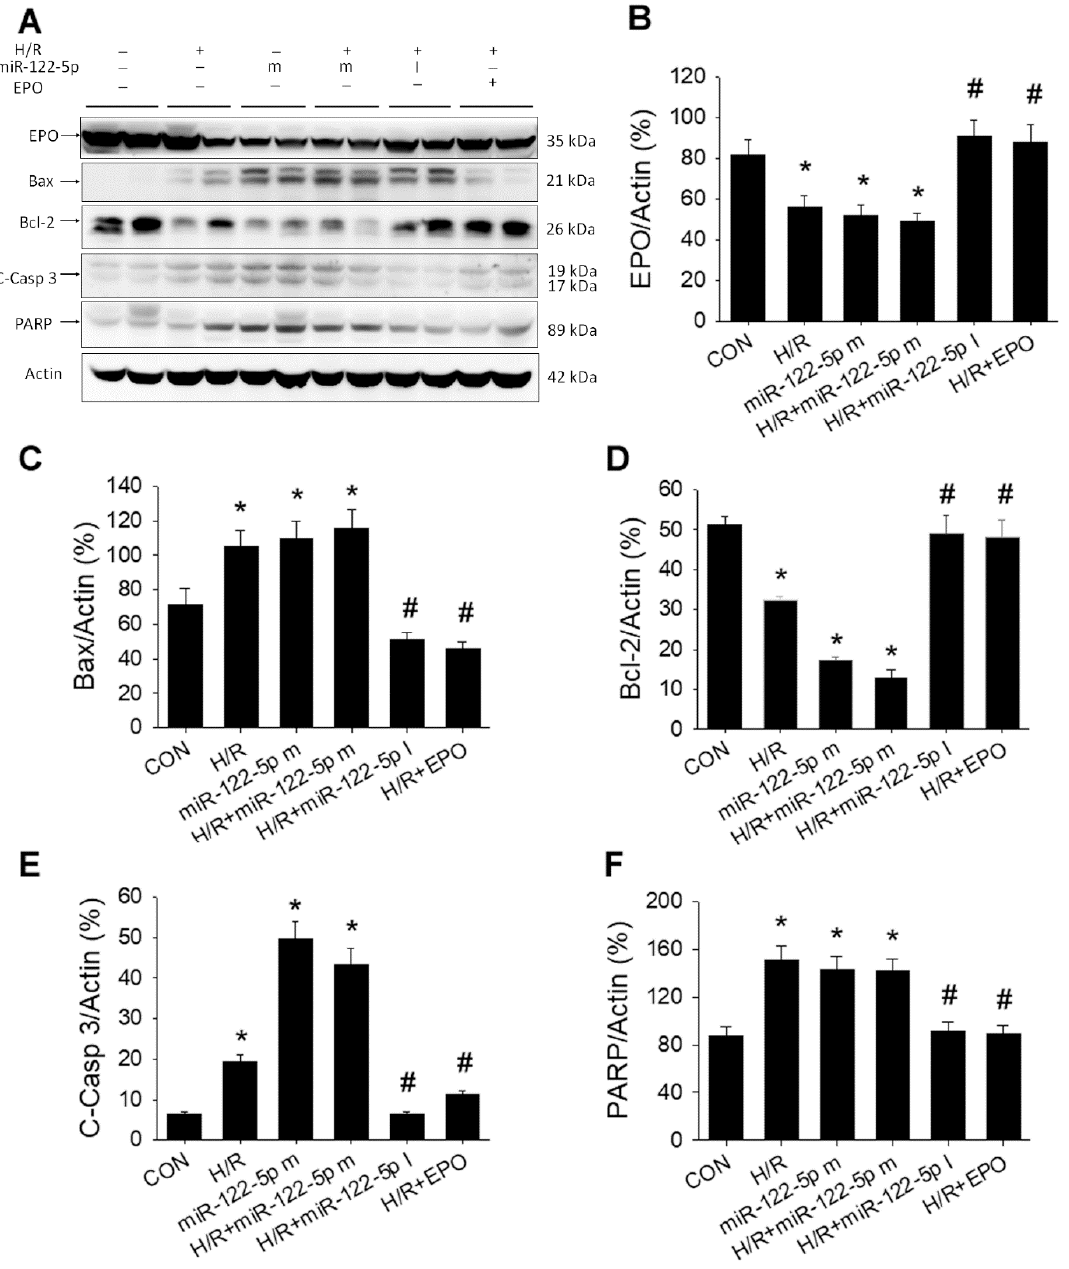
Figure 8. Effect of H/R, miR-122-5p mimics (m), miR-122-5p inhibitor (I), or EPO on EPO, Bax, Bcl-2, C-Casp 3, and PARP expression in NRK-52E cells by Western blot ( A ). ( B ) Statistic data of EPO expression; ( C ) statistic data of Bax expression; ( D ) statistic data of Bcl-2 expression; ( E ) statistic data of C-Caspase 3 expression; and ( F ) Statistic data of PARP expression. Data are expressed as mean ± SEM (n = 3). C-Casp 3, cleaved caspase 3; EPO, erythropoietin; H/R, hypoxia/reoxygenation; PARP, poly-(ADP-ribose)-polymerase; SEM: standard error mean. * p < 0.05 compared with CON group. # p < 0.05 compared with H/R